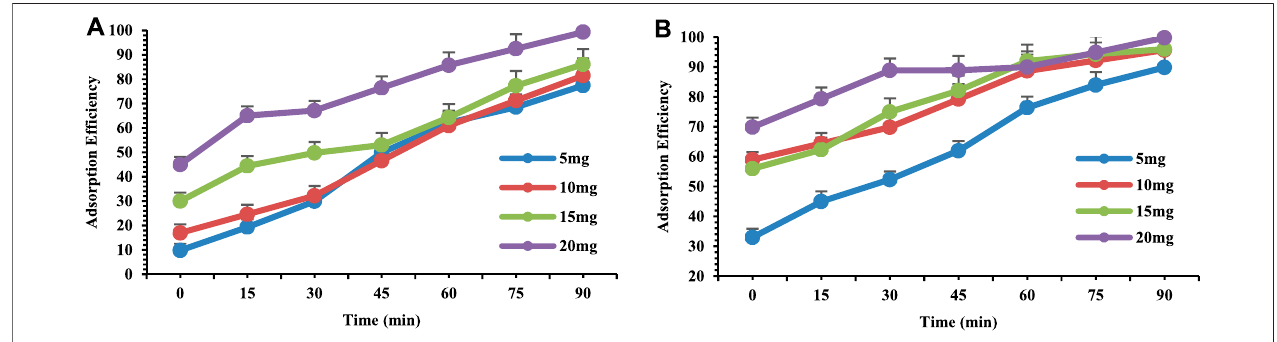
FIGURE 5 | Adsorption ef fi ciency of 10 ppm (A) Chromium and (B) Lead at pH 4 on orange peel/selenium nanocomposite as a function of adsorbent dose.